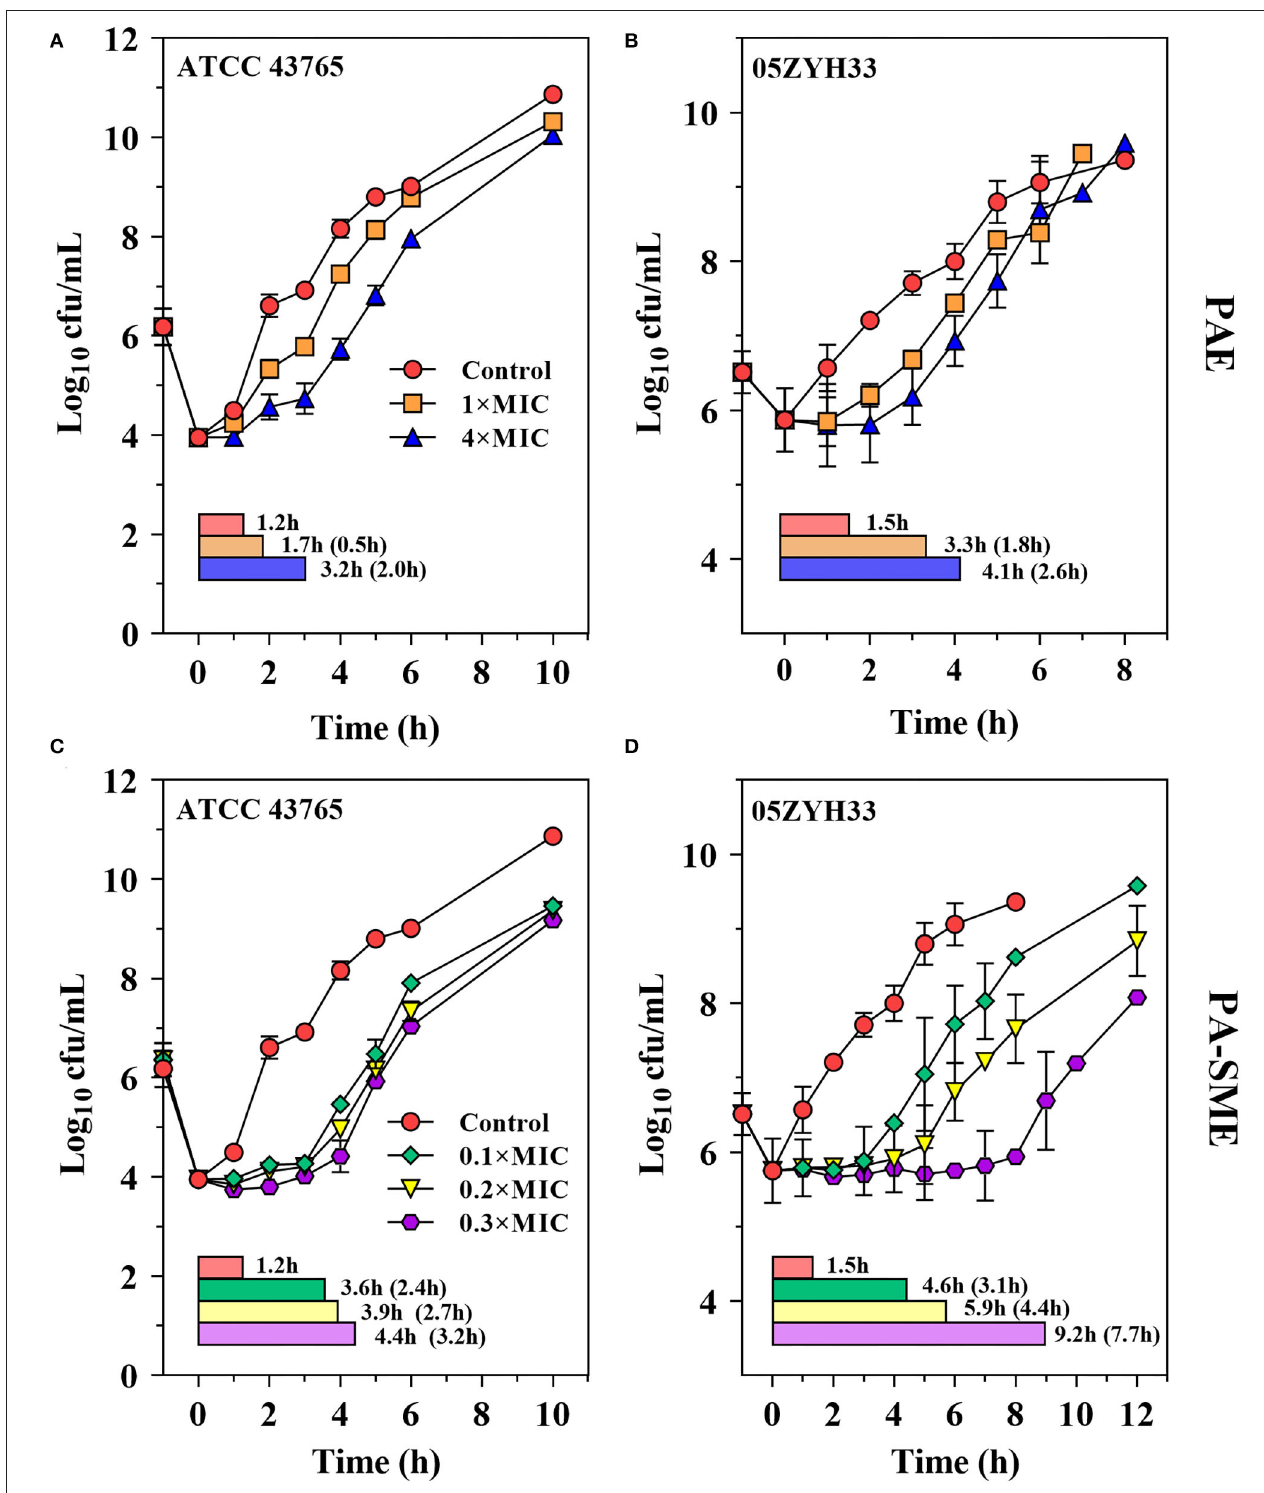
FIGURE 4 | Gamithromycin postantibiotic effect [PAE; (A,B) ] and post-antibiotic sub-MIC effect [PA-SME (C,D )] against S. suis ATCC 43765 and 05ZYH33. The post-antibiotic effects (PAEs) were measured after initial exposures to gamithromycin both at 1 × and 4 × MICs, and the PA-SMEs were measured after exposure to gamithromycin at 4 × MICs. The horizontal bars represent the time that required bacterial counts to increase by 1.0-log 10 CFU/ml after drug removal (PAEs) or at the sub-MIC phases (PA-SMEs).